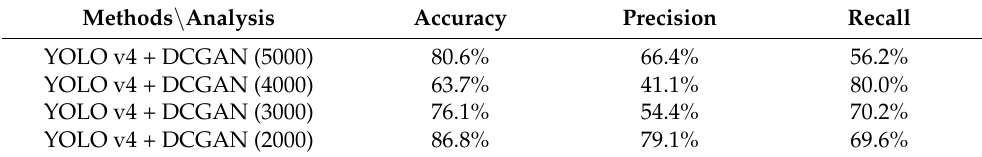
Table 5. Detection accuracy as a function of the number of iterations.